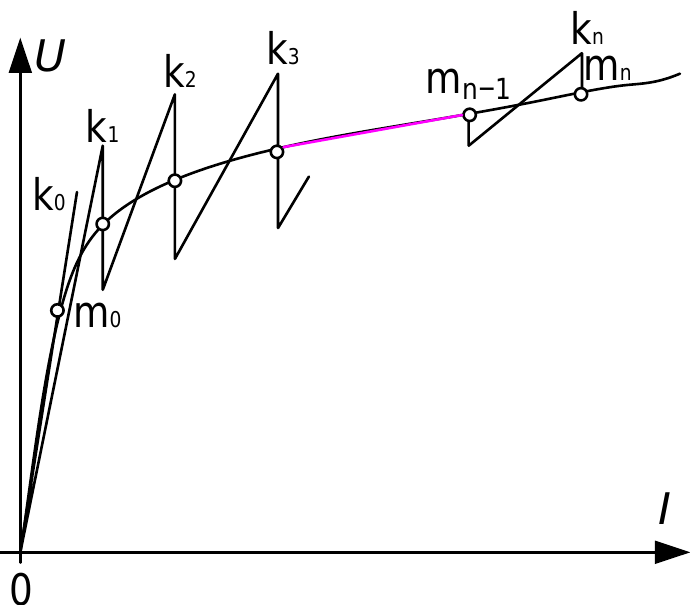
Figure 1. Replacing the magnetization curve with a stepped